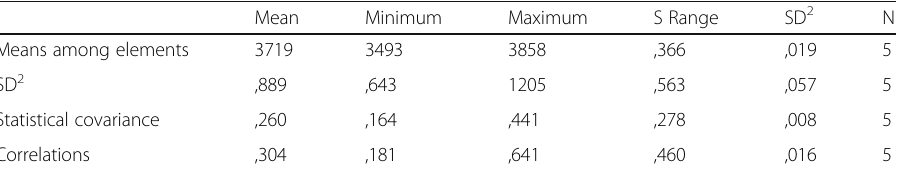
Table 5 Statistics among elements (GS) Mean